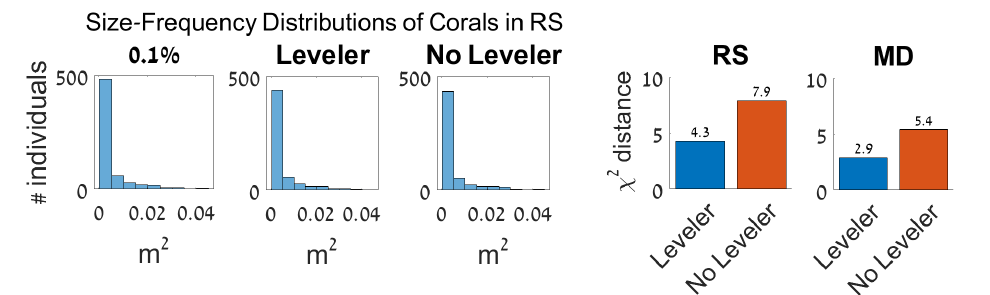
Figure 12. ( Left ) Histograms of the Coral class in the RS data-set. The histogram is divided into nine bins. ( Right ) Average of χ 2 distance between the size-frequency distribution of eight classes. Each photomosaic was compared to its ground-truth: augmented labels from sparsity of 0.1% and the orthorectification further reduces the distance. The distance for photomosaics that have been orthorectified ranges between three to four percent, and for the naïve photomosaics from five to eight percent, with similar effect in both